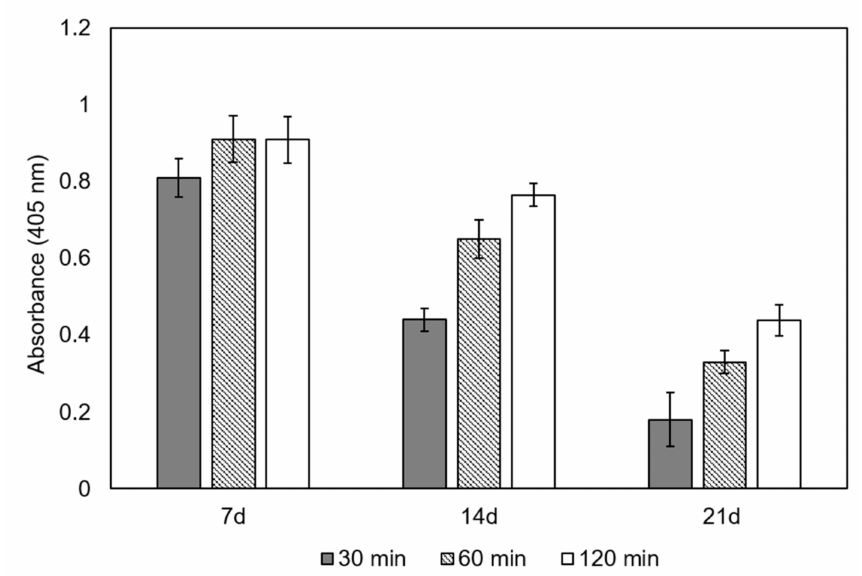
Figure 10. Specific ALP activity in scaffolds at 7, 14 and 21 days after functionalization. The enzyme activity kinetics was quantified after 40, 80 and 120 min of the reaction between the grafted ALP and PNPP